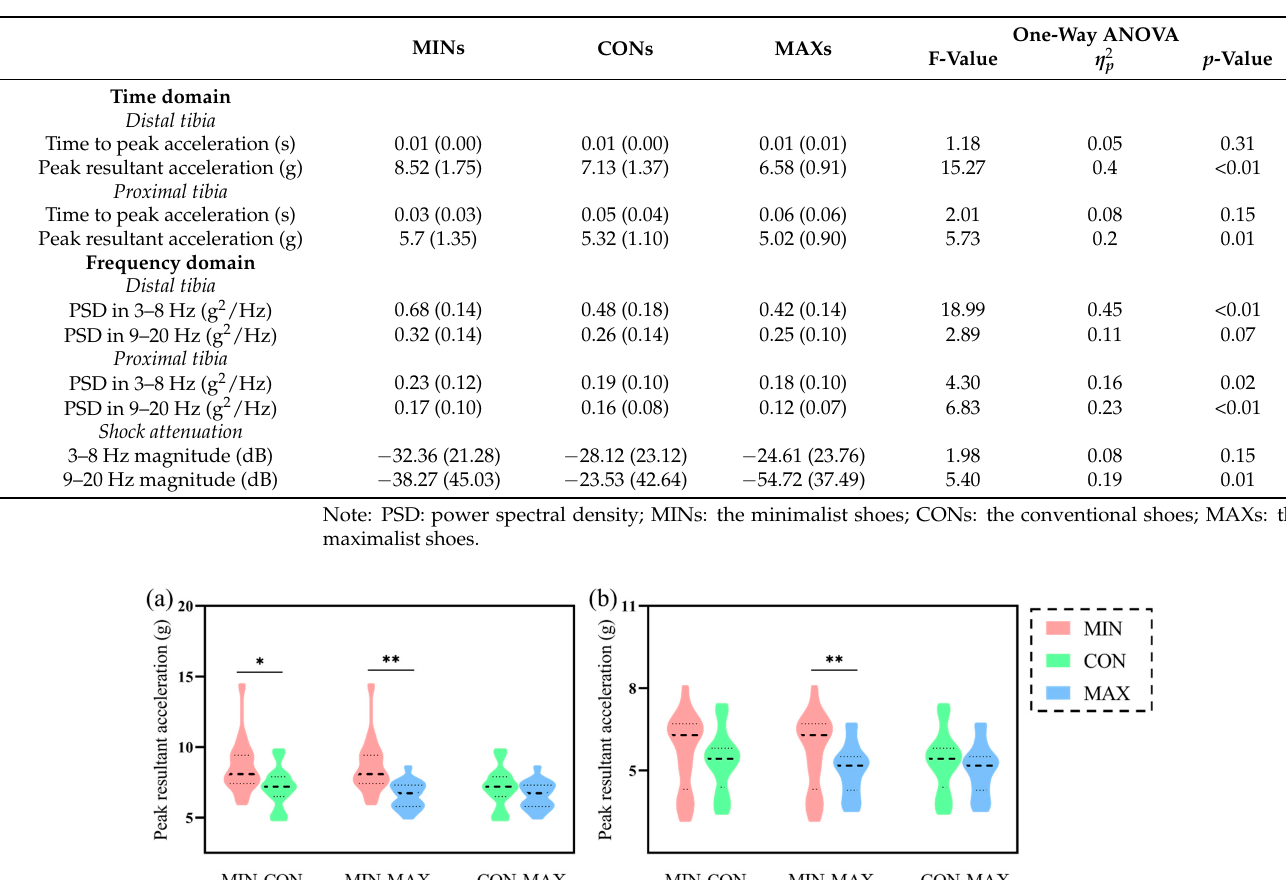
One-Way ANOVA F-Value η 2 p p -Value